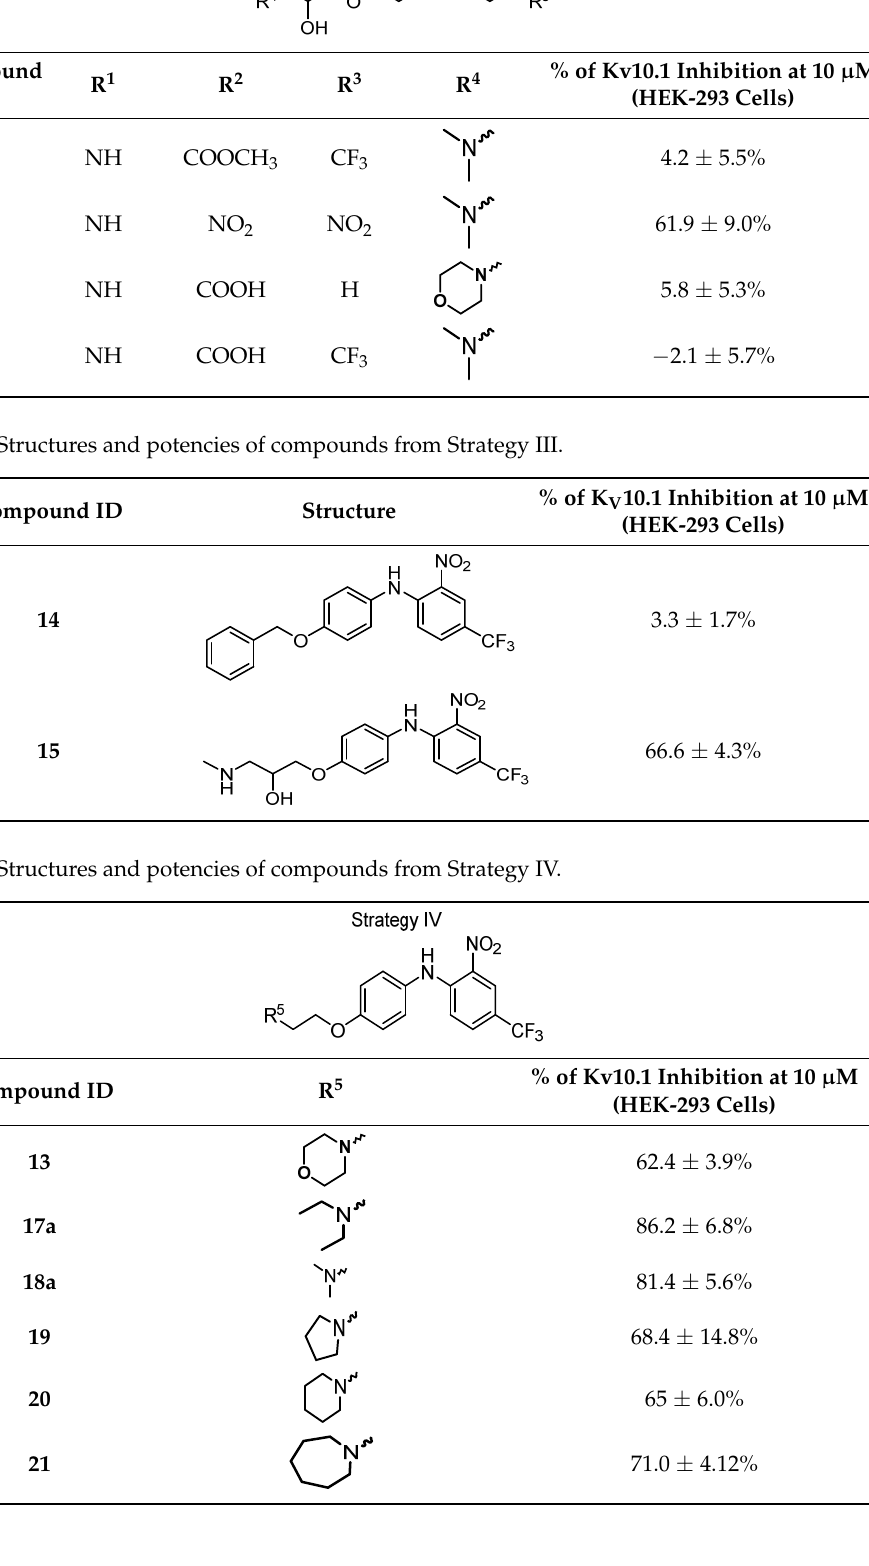
Table 2. Structures and potencies of compounds from Strategy II.